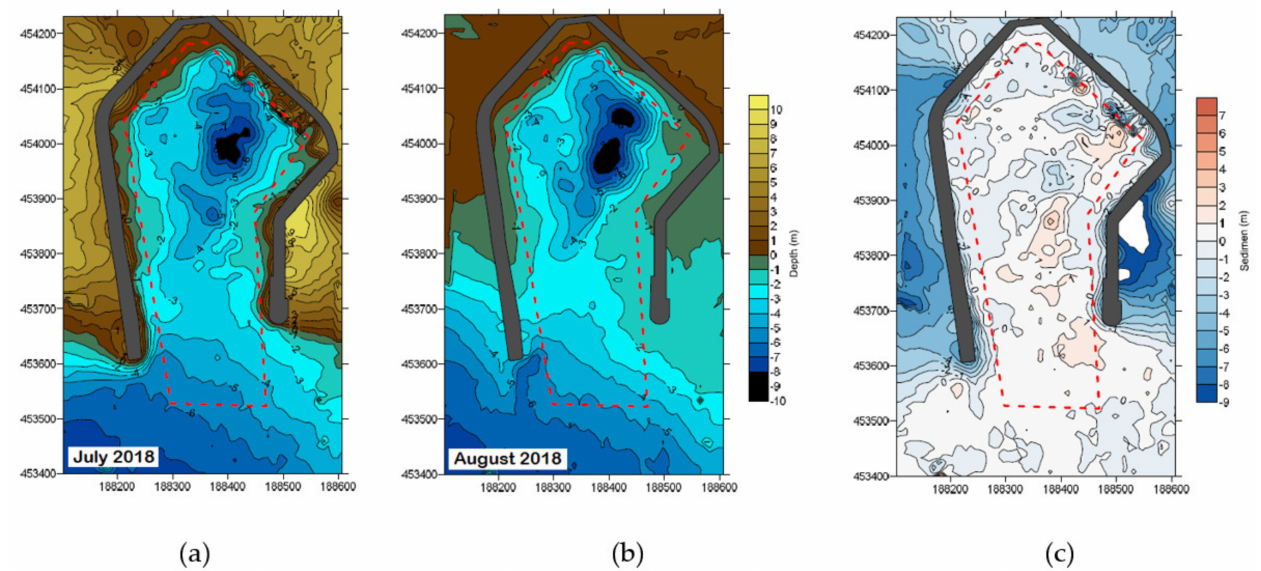
Figure 7. Bathymetric measurement map: ( a ) July 2018, ( b ) August 2018. ( c ) Overlaid